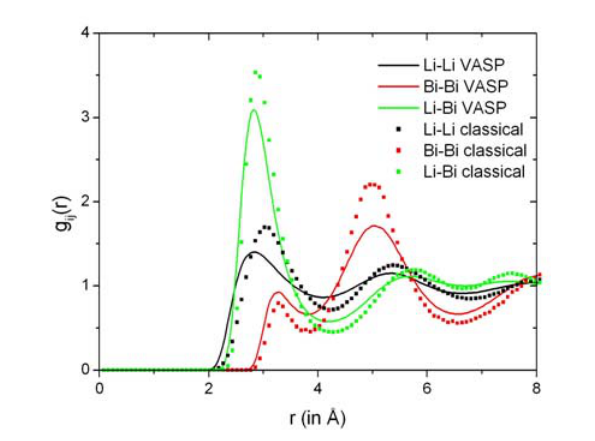
Table 1. Fitted parameters for the 3 pair potentials; units are such that energies are in eV if distances are in Angströms. Li-Li Li-Bi Bi-Bi